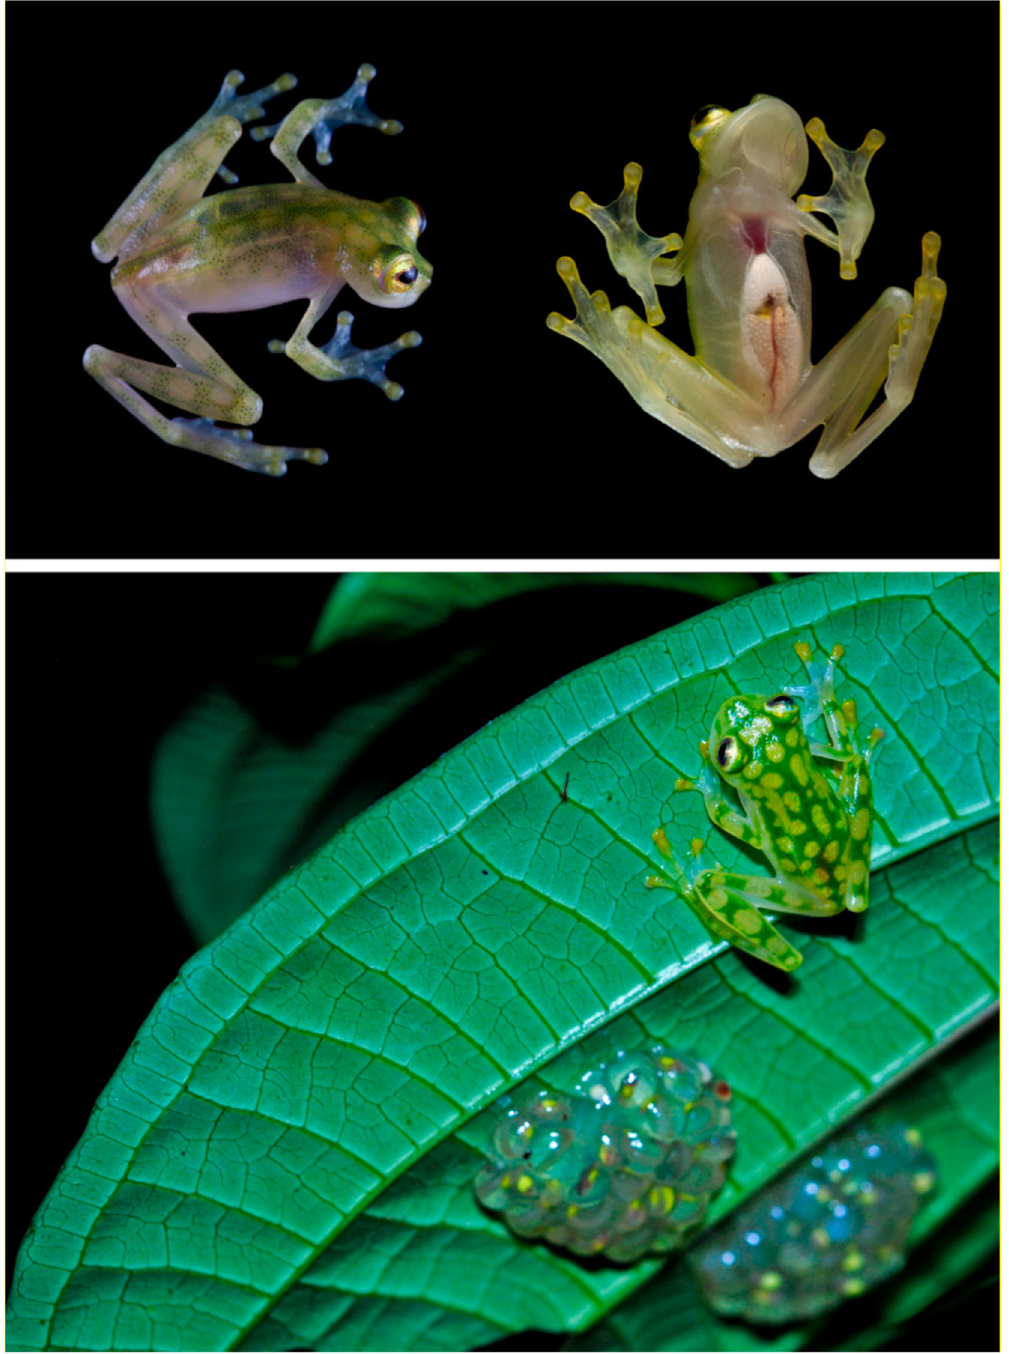
Figure 121. Hyalinobatrachium valerioi in life. ( Top row ): Male from Reserva de Biodiversidad Mashpi, 1080 m, Ecuador; photos by Lucas Bustamante / Tropical Herping. ( Bottom row ): Male guarding eggs, Selva Verde Lodge, Costa Rica; photo by Carlos Mart í nez. Note di ff erences in coloration. Color in life (Figure 121): According to Kubicki [24], dorsum yellowish green with green reticulation. Transparent venter; pericardium varies from white to almost transparent; white liver and digestive tract. Iris golden with dark pigmentation scattered throughout, especially surrounding pupil; several individuals with dark pigmentation restricted to lateral regions of pupil. Bones